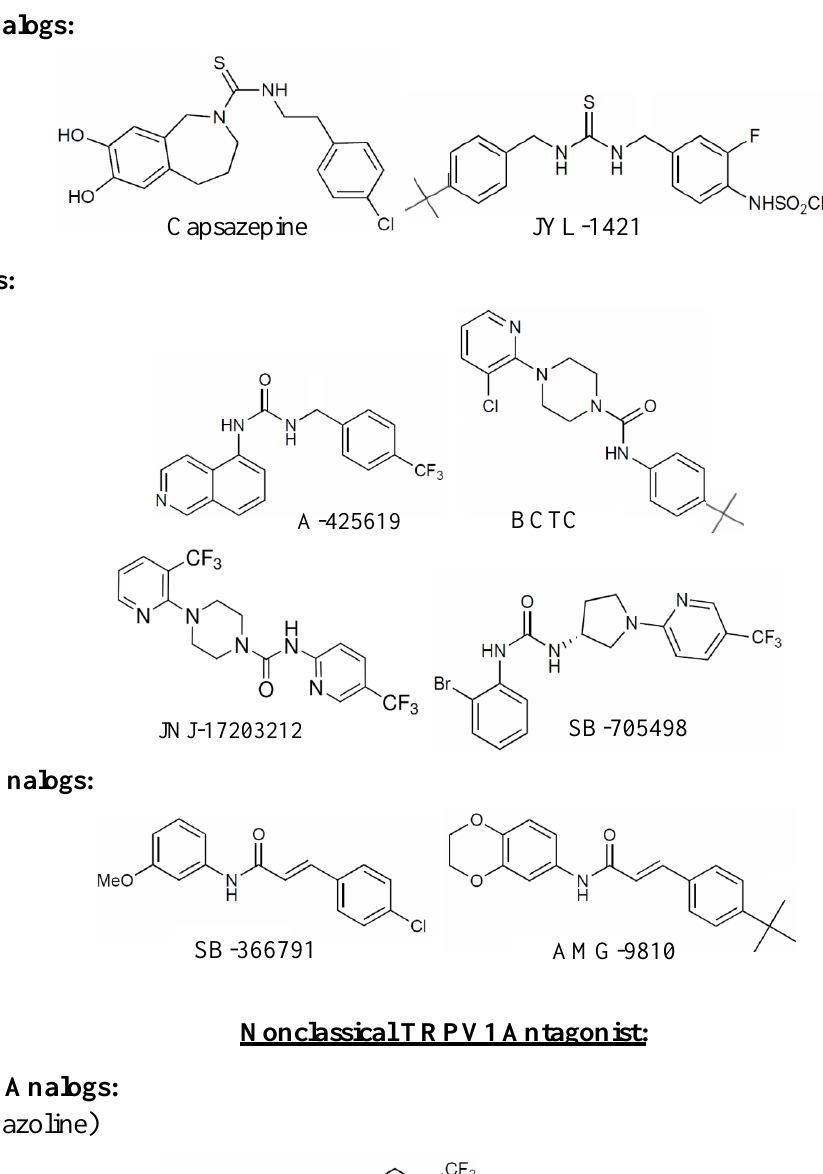
Figure 2. Chemical structures of competitive TRPV1 receptor antagonists. Classical TRPV1